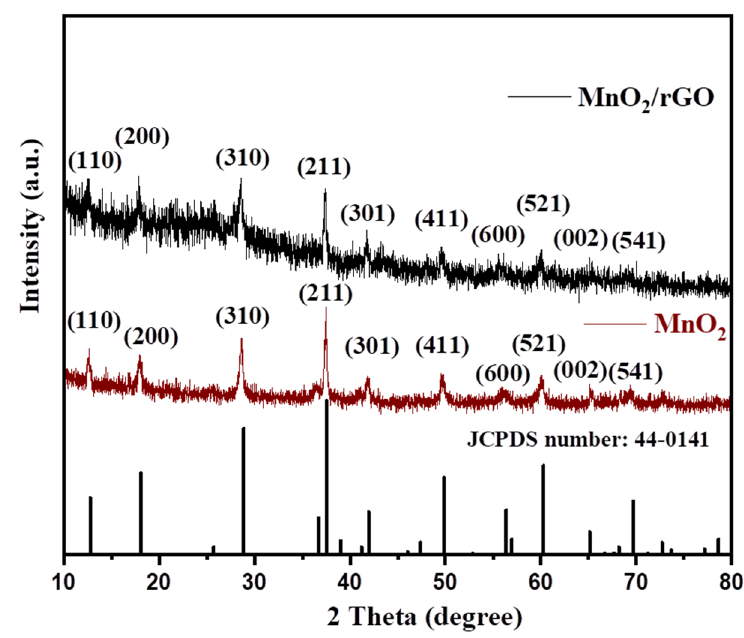
Figure 1. XRD pattern of MnO 2 and MnO 2 /rGO.